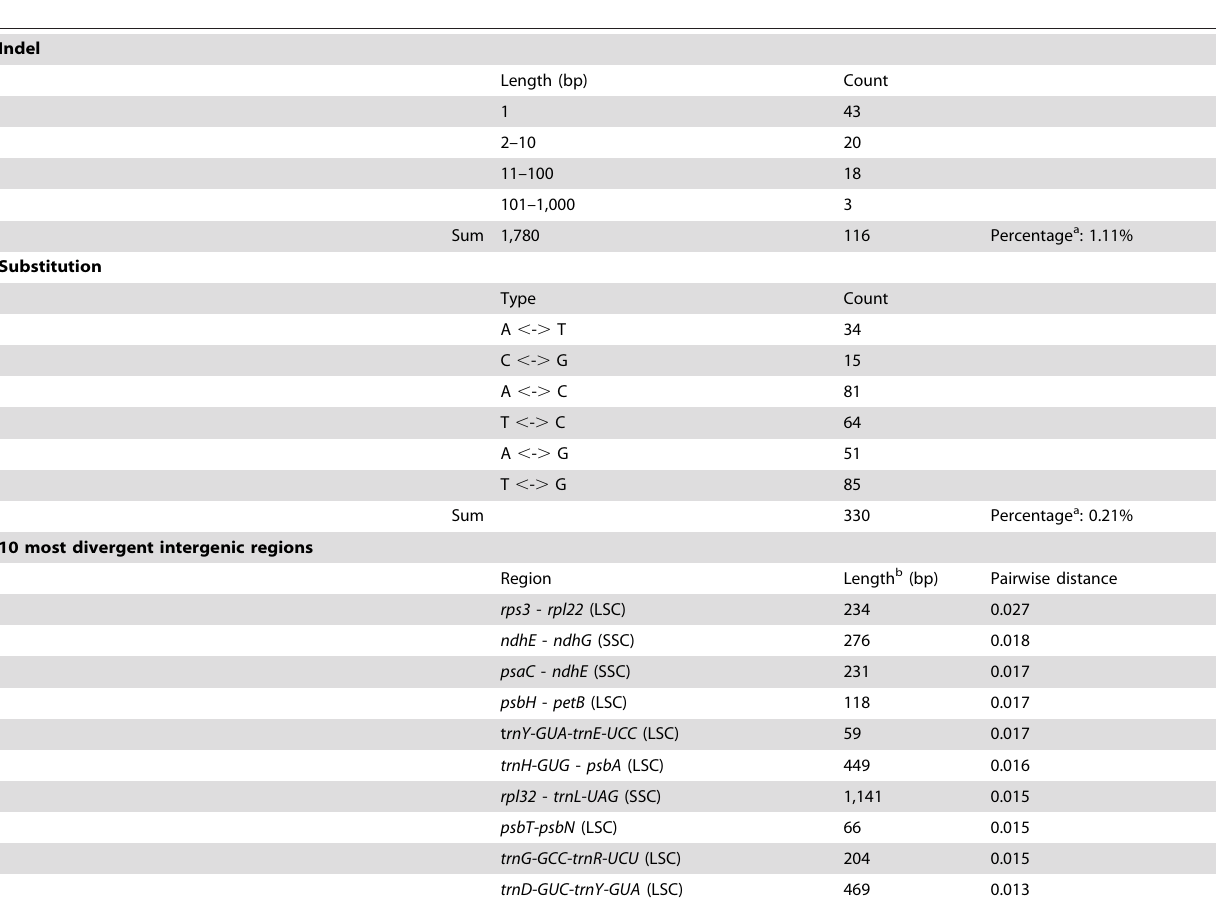
Table 2. Differences between the C. aurantiifolia and C. sinensis cp